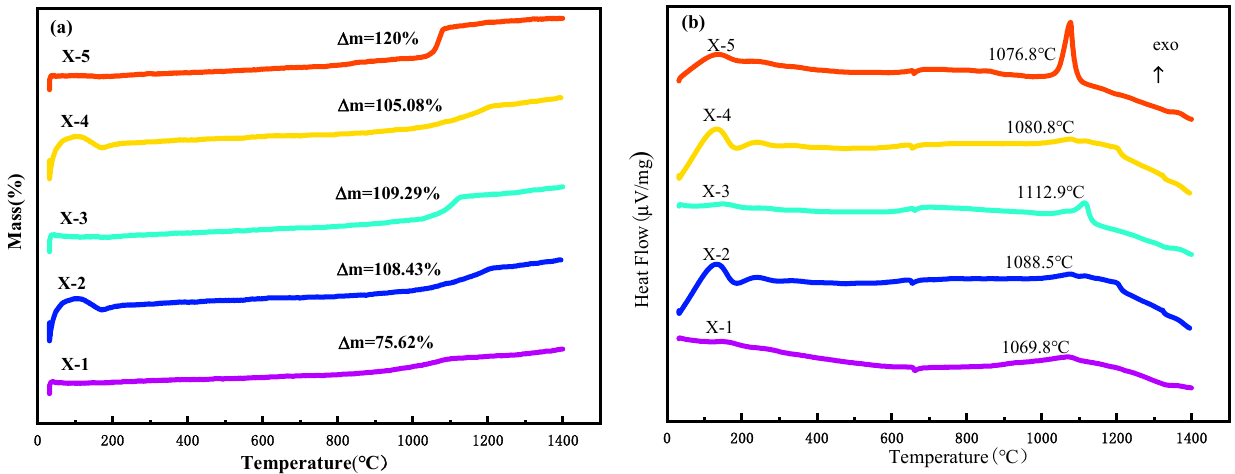
Figure 1. DTA curves and TG curves of Al–2.5Li alloy: ( a ) TG curves; ( b ) DTA curves. Al powder and their mixtures at a heating rate of 20 °C/min in oxygen.